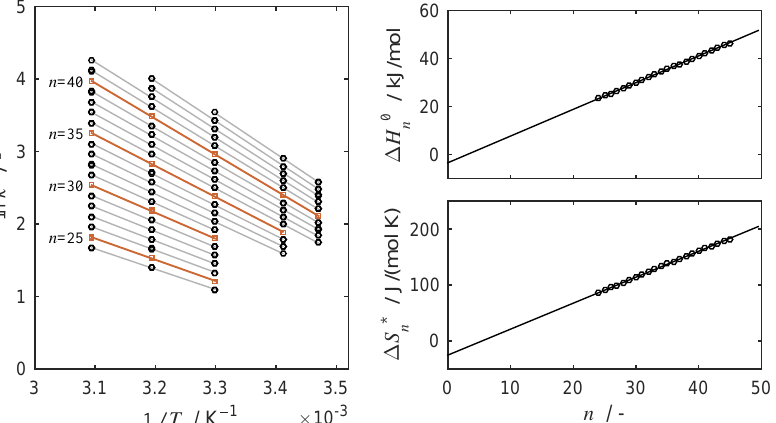
Figure 5. Determination of thermodynamic parameters for PEG1400 at the same conditions as in Figure 1 (left) (25 vol % acetonitrile). Left —van’t Hoff plot of data (symbols, triplicate measurements) and linear regression against Equation (5) (lines) for the different homologs. Right —enthalpic and entropic contributions as a function of n corresponding to the slopes ( ∆ H 0 n ) and intercepts ( ∆ S ∗ n ) of the lines in the left (symbols). Linear regression against Equation (6) (lines) delivers ∆ H 0 r , ∆ H 0 e and ∆ S ∗ ∆ S ∗ r , e as slopes and intercepts,